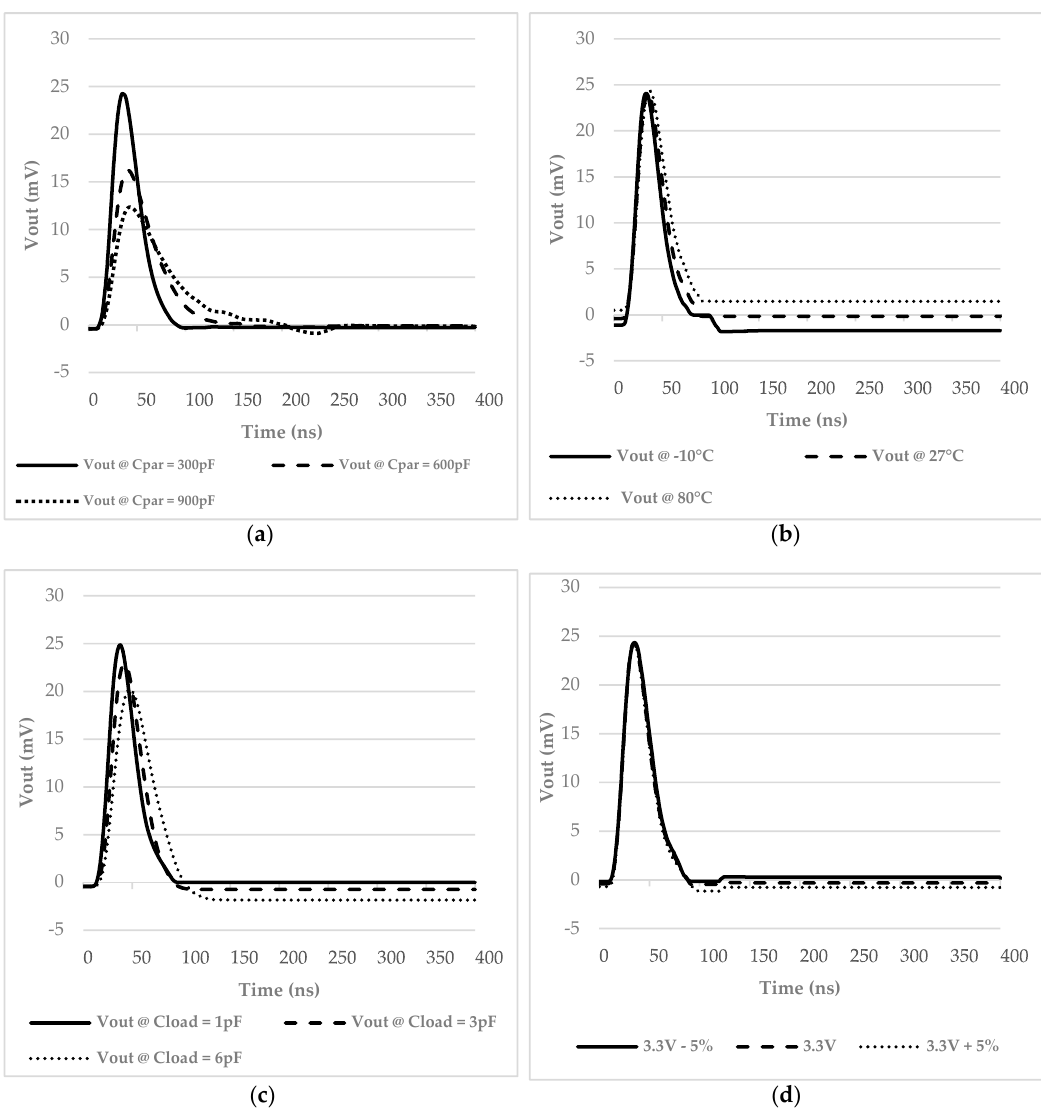
Figure 8. ( a ) Time domain output voltage for different parasitic capacitances, simulating the interface to be used with an array of SiPMs; ( b ) interface output voltage variations at different temperatures; ( c ) interface output voltage for three different capacitive loads connected to the VCII Z node; ( d ) interface output voltage for ±5% supply voltage variations.